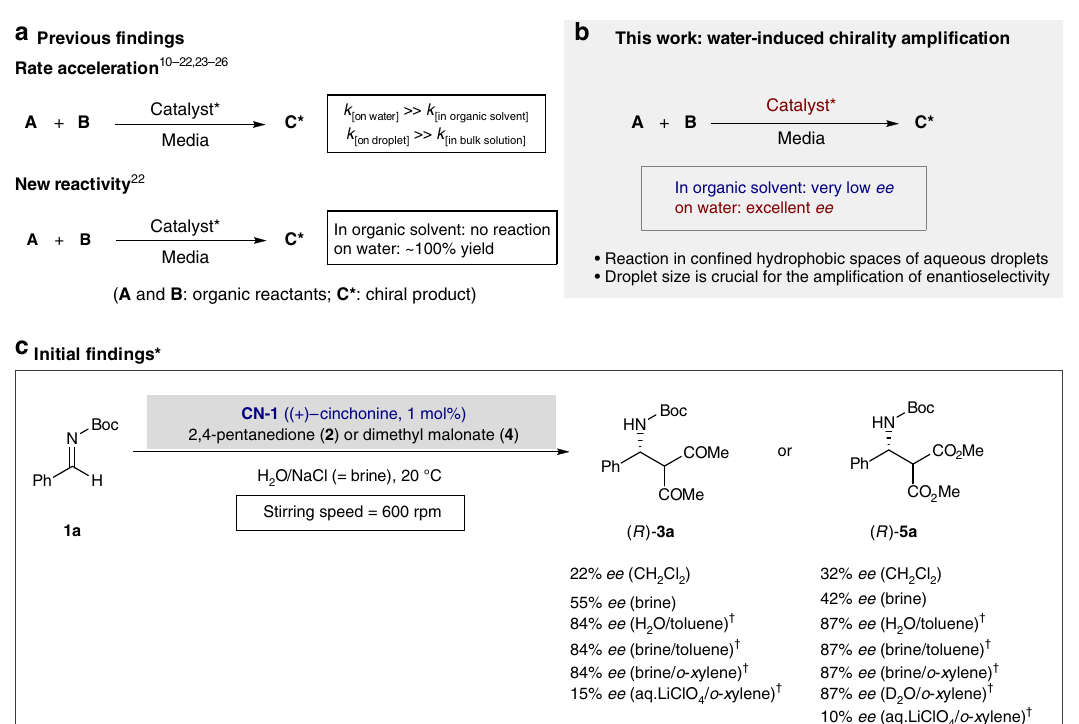
Fig. 1 Concepts and initial fi ndings on the water-induced hydrophobic ampli fi cation. a Previously observed rate acceleration under on-water and on-droplet conditions. b First observation of the chirality ampli fi cation under on-water conditions. c Mannich reaction with imine ( 1a ) with 2,4-pentanedione ( 2 ) or dimethyl malonate ( 4 ) in various reaction media. *Conditions: Imine 1a (0.3 mmol), 2,4-pentanedione 2 or dimethyl malonate 4 (0.6 mmol), and catalyst CN-1 (( + )-cinchonine, 1 mol%) with 2.0 mL of reaction media at 20 o C for 1 h (for 2 ) or 24 h (for 4 ). † Toluene or o -xylene (15 equiv) was used as an additive. § See Supplementary Table 1 for more experimental results. ee = enantiomeric excess; Rpm = revolutions per minute; Boc = tert